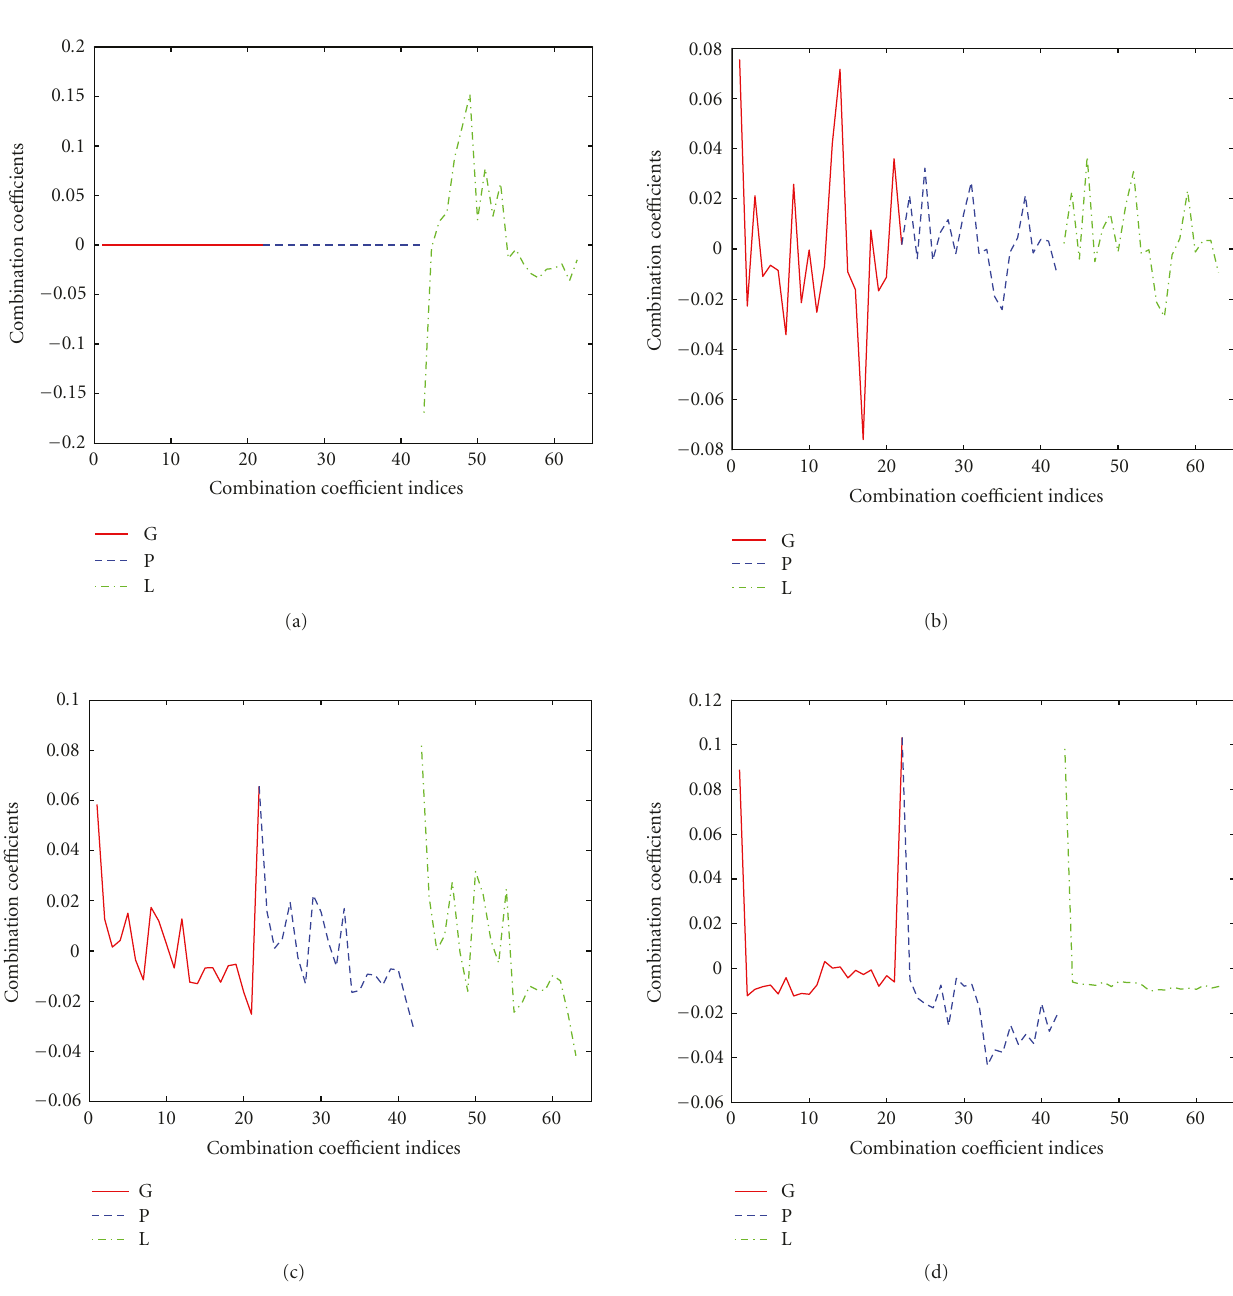
Citation S/II, are measured continuously when the targets are flying. The projections of target trajectories onto the ground plane are shown in Figure 4. The measured data of each tar- get are divided into several segments, the training data and test data are chosen from di ff erent data segments, respec- tively, which means, the target orientations corresponding to the test data and training data are di ff erent, the maximum elevation di ff erence between the test data and training data is about 5 degrees. The 2nd and the 5th segments of